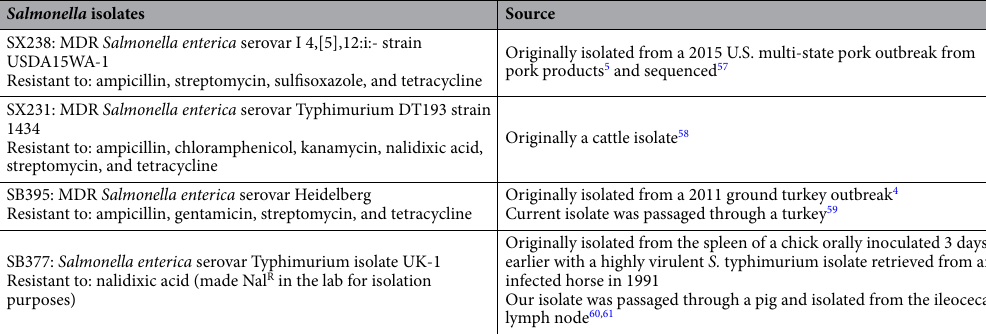
Table 1. Sources and properties of MDR and non-MDR Salmonella